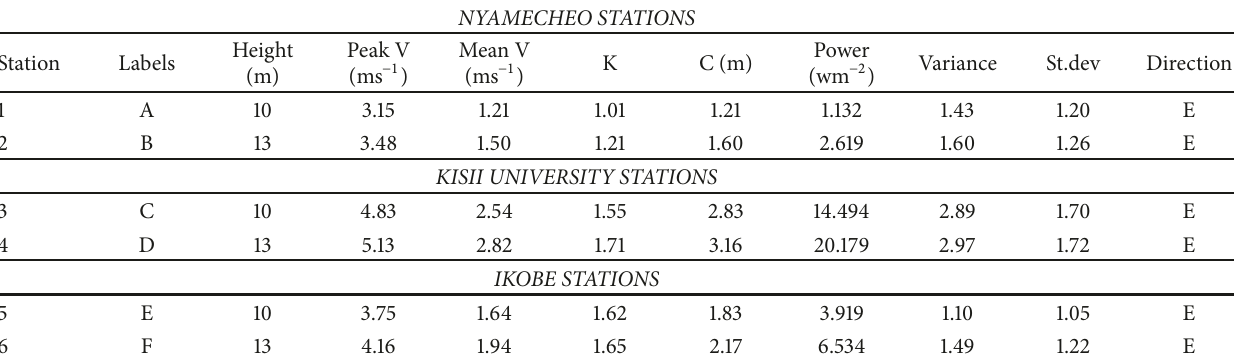
Figure 13: Diurnal variation of surface roughness parameter and wind speeds at the sites. Table 4: Statistical summary of wind characteristics at the